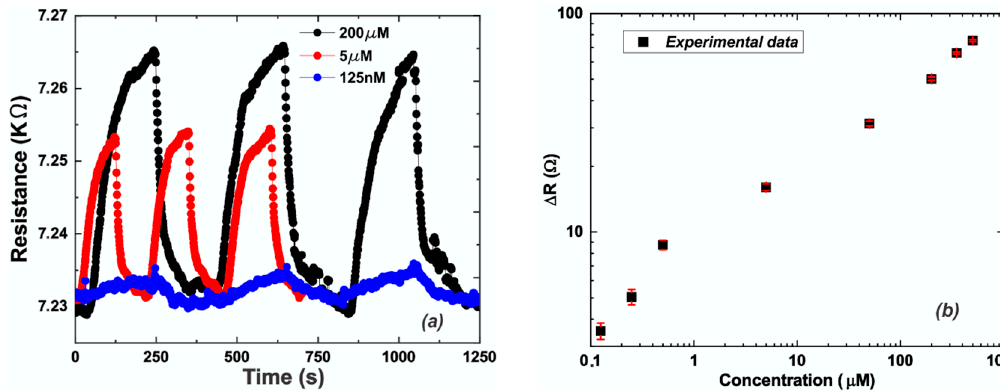
Figure 3. ( a ) Sensor signal (resistance) versus time for Pb 2 + concentration of: 0.125 (blue line), 5 (red line), 200 µ M (black line); ( b ) Calibration curve: experimental data (black squares) and relative error bars (red lines).